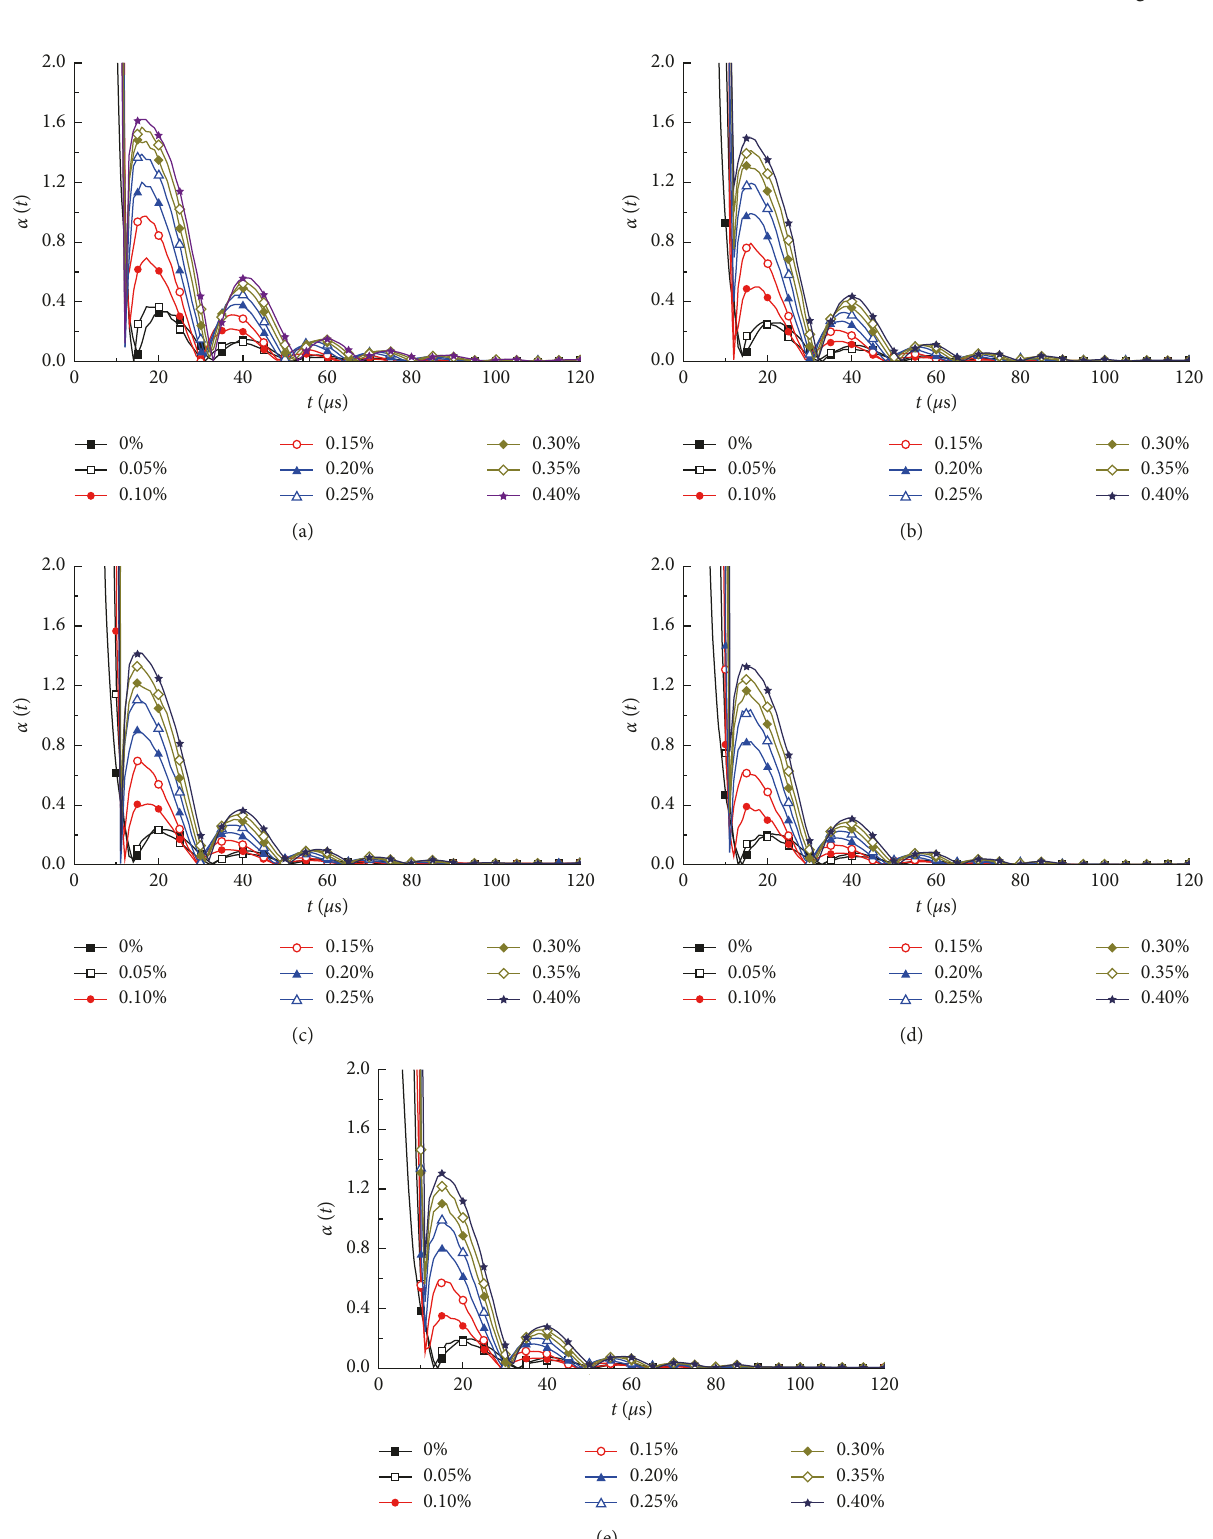
t for various end-surface nonparallelisms and Young’s moduli: (a) E ( ) (cid:30)